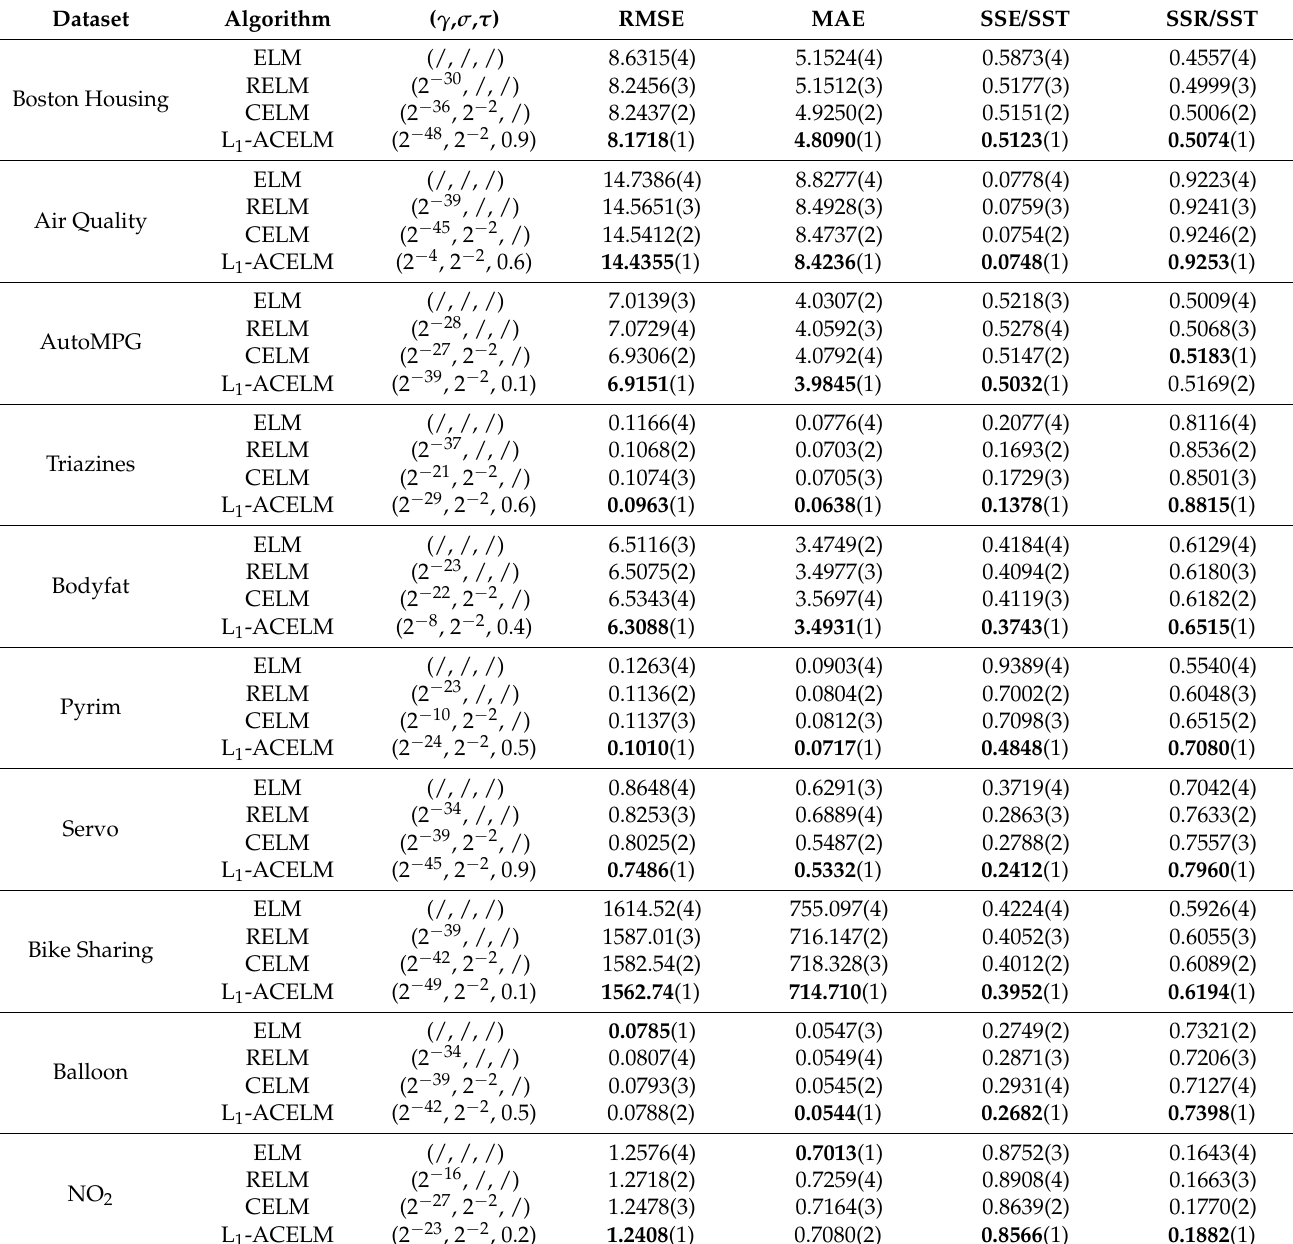
Table 6. Performance of different algorithms under 10% noise